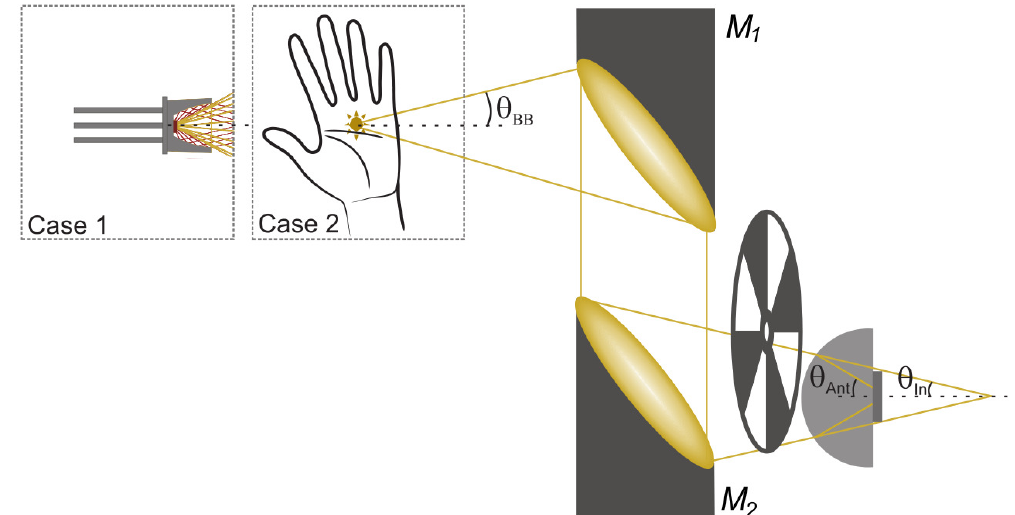
Figure 4. Set-up for the detection of thermal radiation from either the ceramic thermal source or a human palm. The commercially available ceramic radiator comes mounted in the center of a small paraboloidal reflector. M 1 and M 2 denote the paraboloidal mirrors. They have equal focal lengths FL; the optical arrangement is in an aberration-free 4-FL optical relay configuration. The thermal signal is either electrically or mechanically chopped at 77 Hz before entering the substrate lens of the TeraFET detector. θ BB , θ In = θ BB , and θ Ant denote the beam acceptance angles of M 1 , M 2 and the antenna.